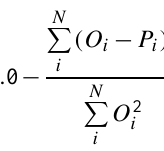
The RMSE indicates that the BNN model perform well than the ANN and the AR (1) model in the training, validation and the test period (smaller RMSE) (Figs. 8–12, Table 1). The two quantities RE (reduction of error) and the “ d ” (index of agreement) in Eqs. (10) and (11) are, respectively, the mea- sures of the predictive ability of the models. Any positive value indicates that the reconstruction has some predictive